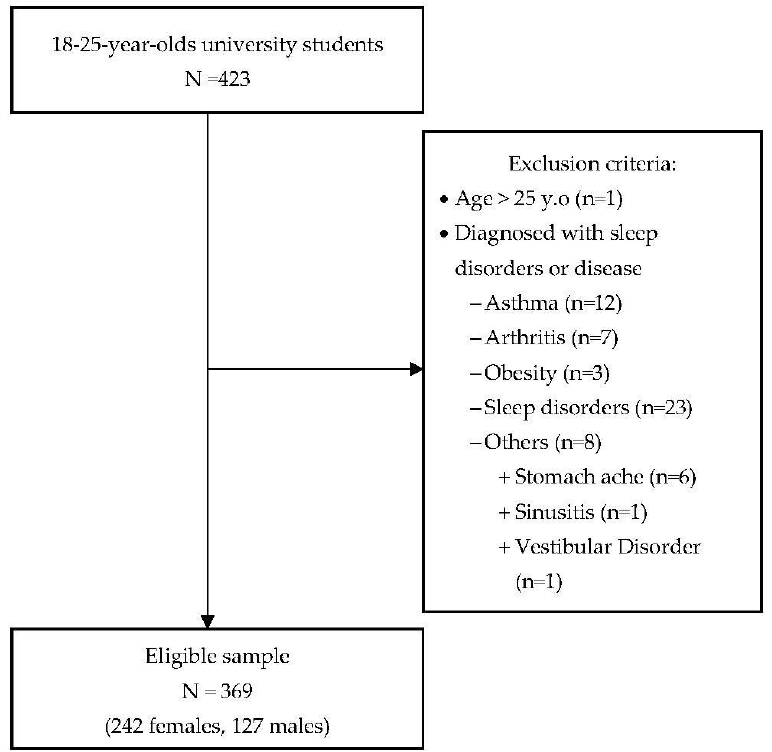
Figure 1. Flowchart of the participants’ selection process.